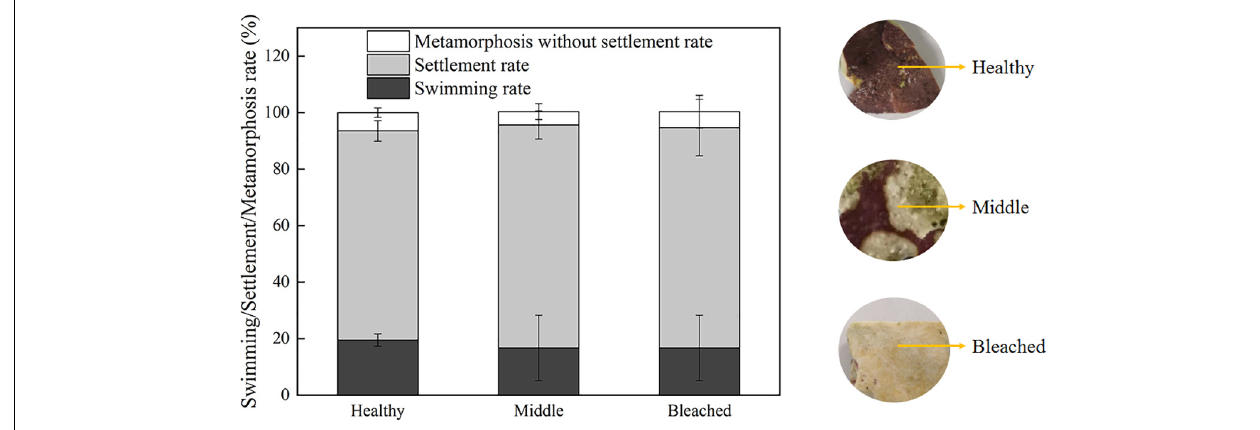
FIGURE 1 | Settlement/metamorphosis rates of P. damicornis larvae exposed to different health statuses of P. onkodes at 24 h.